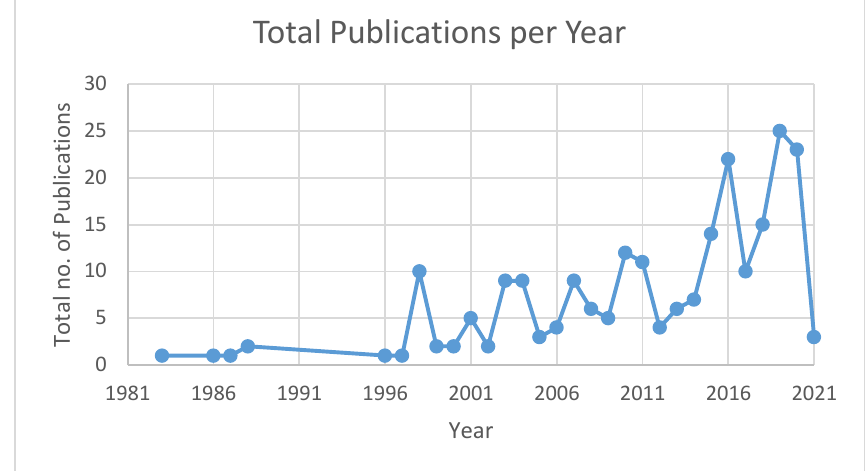
Figure 2. Number of publications per year.